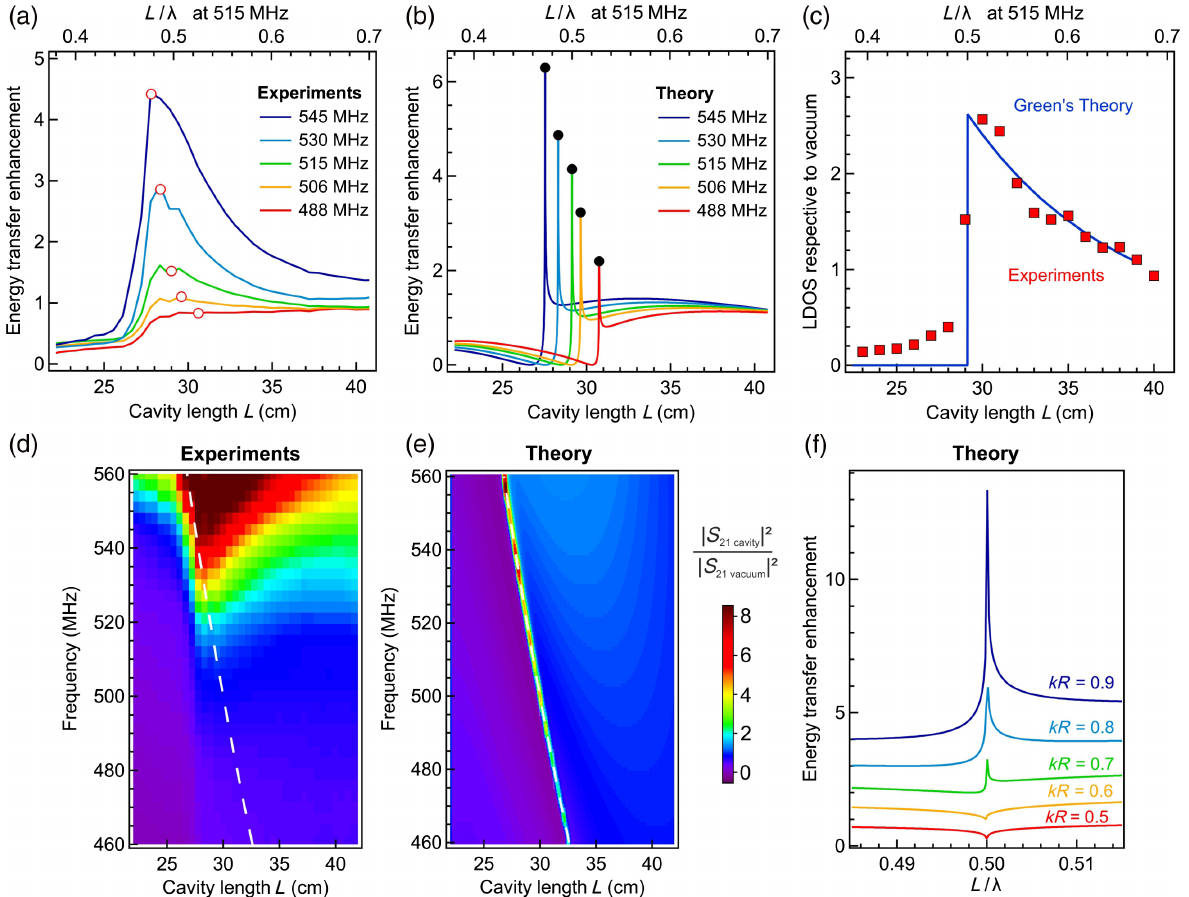
FIG. 2. Dipole-dipole energy transfer in a cavity. (a) Measured energy-transfer enhancement factor [Eq. (9)] between two dipoles versus cavity length, for different frequencies. The two dipoles are oriented parallel to each other and parallel to the mirror plates forming the cavity. From top to bottom, the different frequencies correspond to kR values of 0.87, 0.84, 0.82, 0.80, and 0.77, respectively. The white disks indicate the cavity length that maximizes the energy transfer. It shifts to lower values with increasing frequency. (b) Simulations using Eq. (9) of the experimental results in (a). Because of the finite-size effects, the sharp peaks obtained at resonance (black disks) are smoothed in the experimental data in (a), but the main features (peak position and relative amplitude) are preserved as the frequency is tuned. (c) LDOS enhancement (Purcell factor) versus cavity length at 515 MHz, for a single dipole at 11.2 cm from the nearest mirror with orientation parallel to the mirrors. The blue line is the prediction from Green ’ s function theory while the red squares are experimental data. (d),(e) Energy-transfer enhancement versus cavity length and frequency. The experimental data (d) and the simulations (e) share the same color scale. The white dashed line represents the expected trend L ¼ λ = 2 for the resonance condition. (f) Simulated evolution of the energy-transfer enhancement around the resonance for increasing dipole-dipole separations R as function of the normalized cavity length L= λ . For clarity, the curves are vertically shifted by þ 1